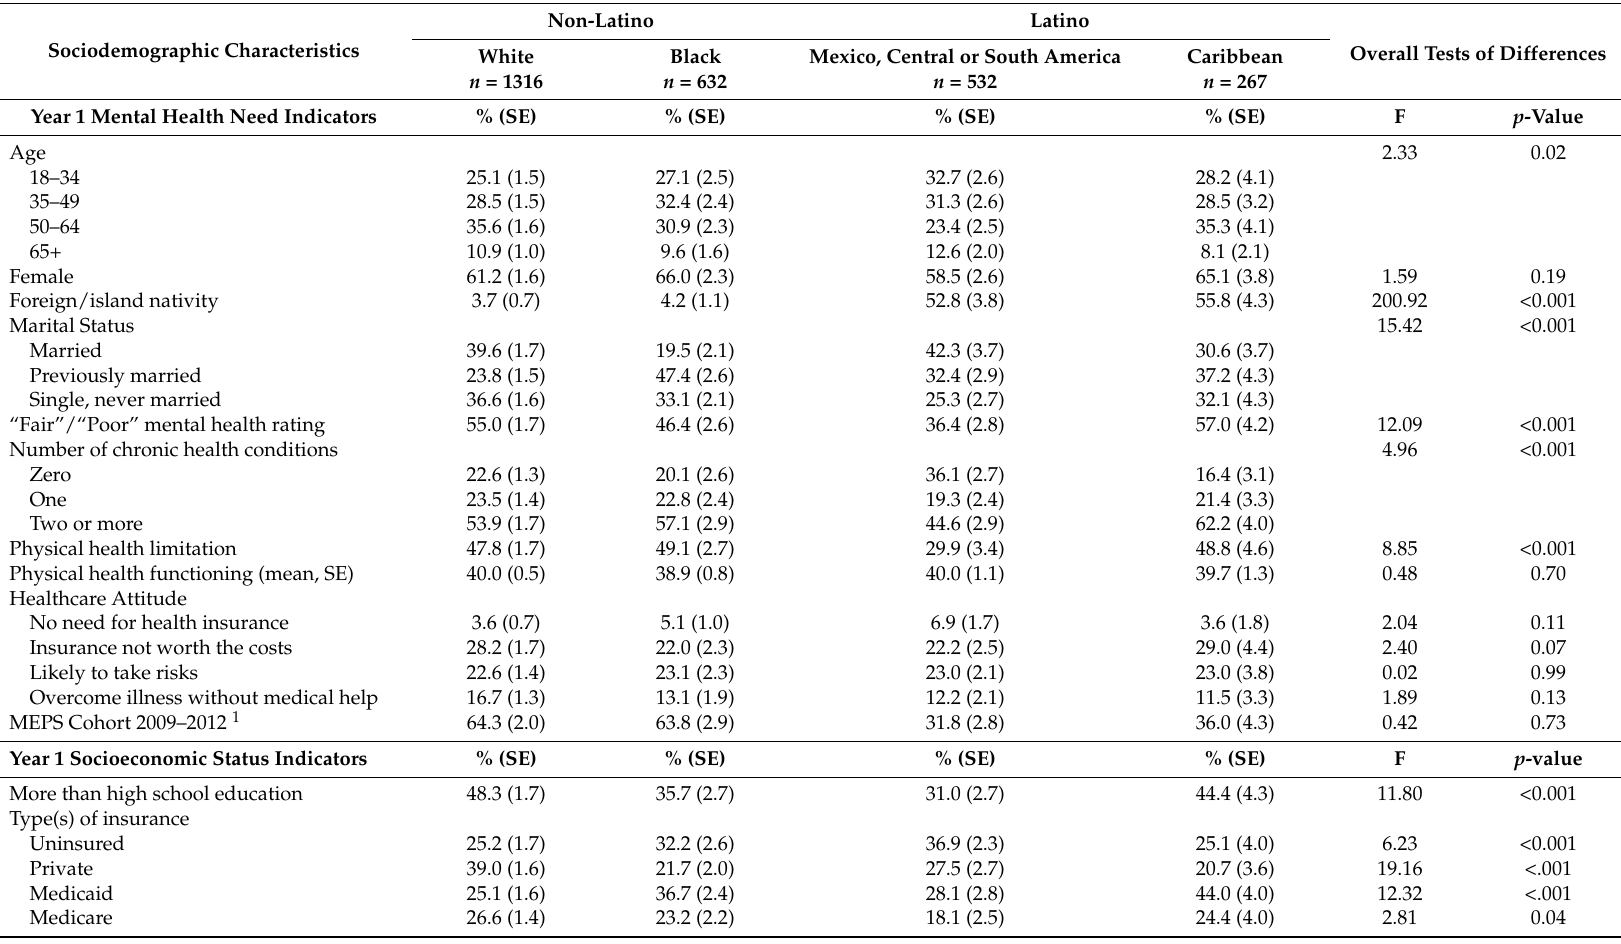
Table 1. Sociodemographic Characteristics of Non-Latino White, Non-Latino Black, and Latino Adults with Serious Psychological Distress, 2010–2015.